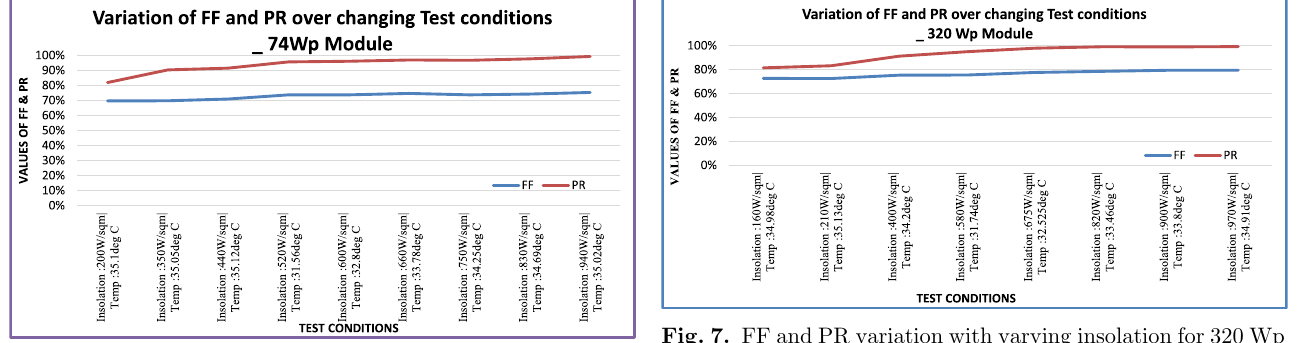
Fig. 5. FF and PR variation with varying insolation for 74 Wp PV modules.